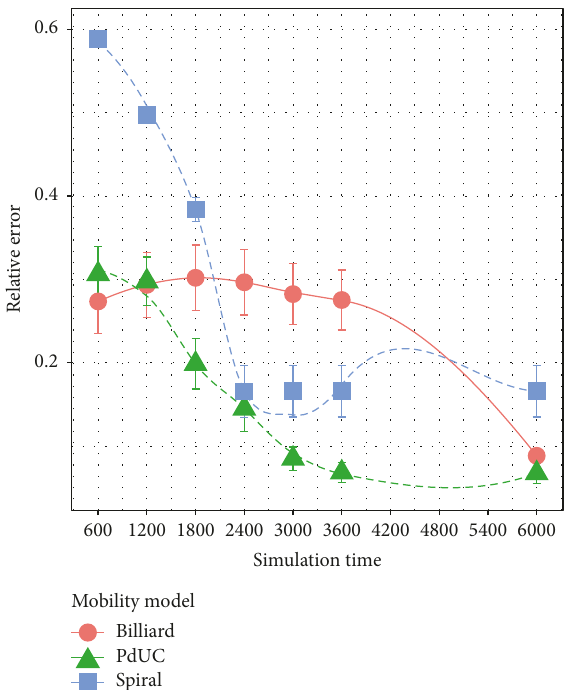
Figure 13: Relative error comparison between PdUC, Billiard, and Spiral mobility models at different times when only considering values higher than 120ppb.